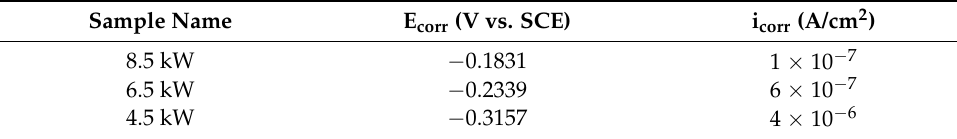
Table 3. E corr and i corr values of welded duplex 2205 stainless steel in 3.5% NaCl solution.